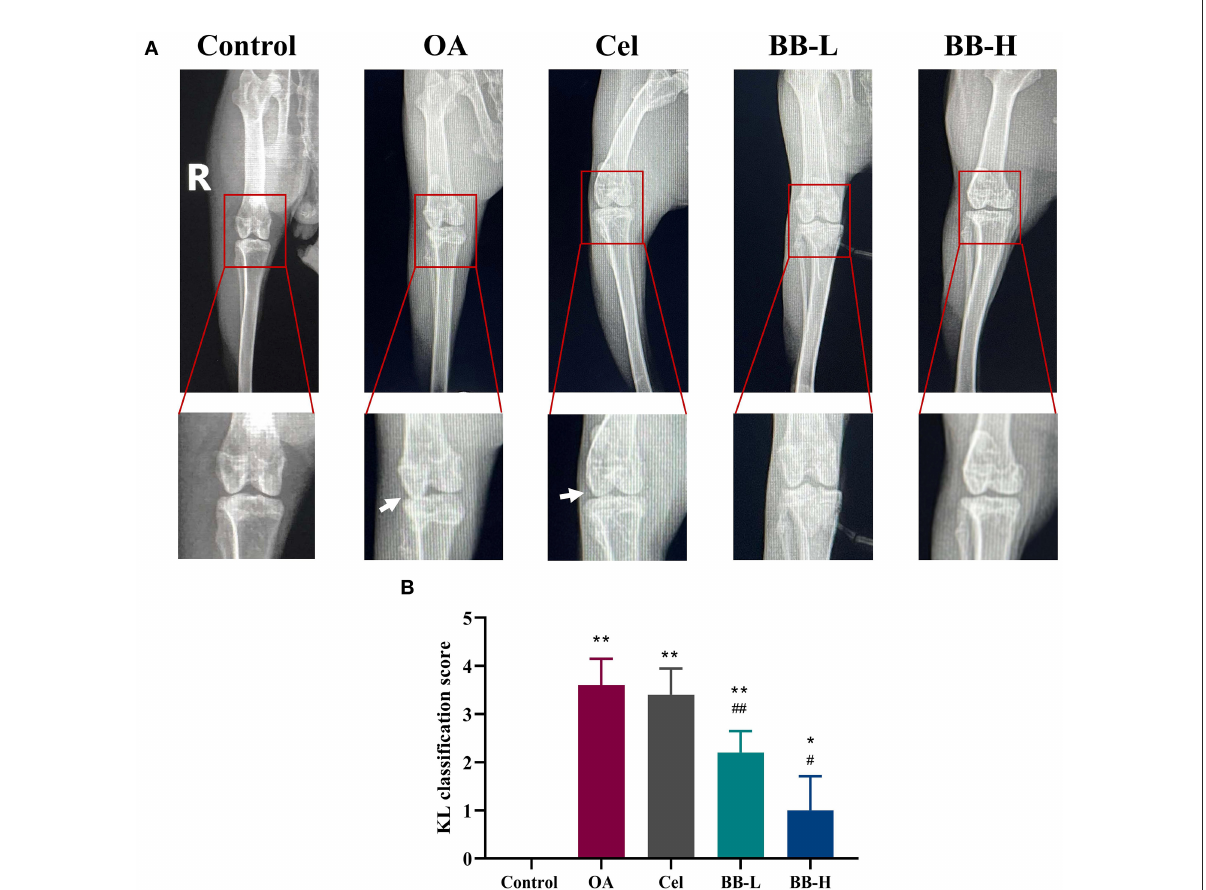
FIGURE2 X-ray images of the knee joints of rabbits in each group after 8 weeks of bilobalide treatment. Arrows depict the knee joint’s articular cartilage damage and shrinken joint space. (A) X-ray images of the knee in each group. (B) KL classification score for the knee in each group. All data are presented as mean ± SD ( n = 3). * p < 0.05 and ** p < 0.01 vs. control group; # p < 0.05 and ## p < 0.01 vs. OA group.